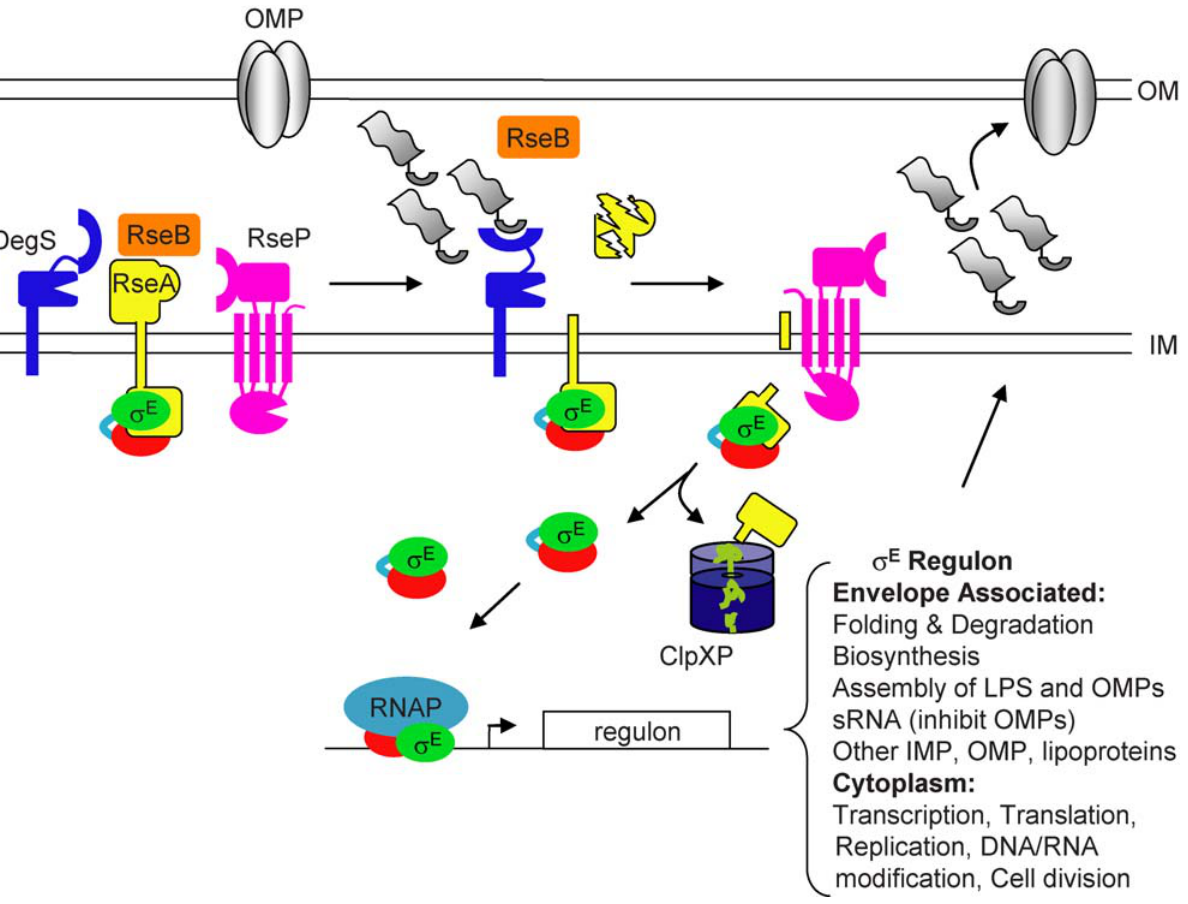
Figure 1. The s E -dependent extracytoplasmic stress response. s E is held at the membrane by the antisigma factor RseA. RseB binds to the periplasmic domain of RseA and protects RseA from proteolysis. Unfolded OMPs activate the protease DegS, which cleaves the periplasmic domain of RseA. The partially degraded RseA is now a substrate for RseP. RseP cleaves RseA further, releasing the cytoplasmic domain of RseA bound to s E . This remaining domain of RseA is degraded by ClpXP thereby freeing s E to interact with RNA polymerase and direct transcription of its regulon. The major classes of known genes in the s E regulon are indicated. The alarmone ppGpp and protein DksA can activate s E -dependent transcription once s E is released from RseA, but are not shown for clarity. (IM inner membrane, OM outer membrane).